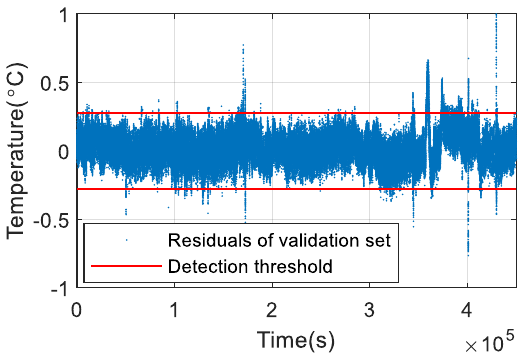
Figure 16. Residuals in validation set.